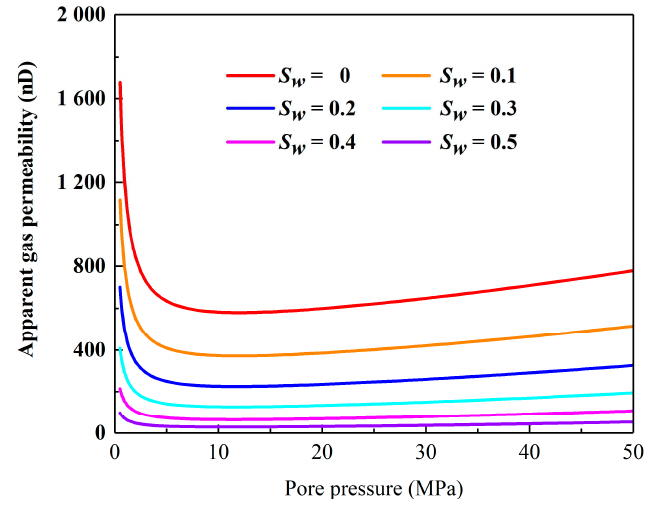
Figure 11. AGP in inorganic pore at different water saturation ( h = 30 nm).